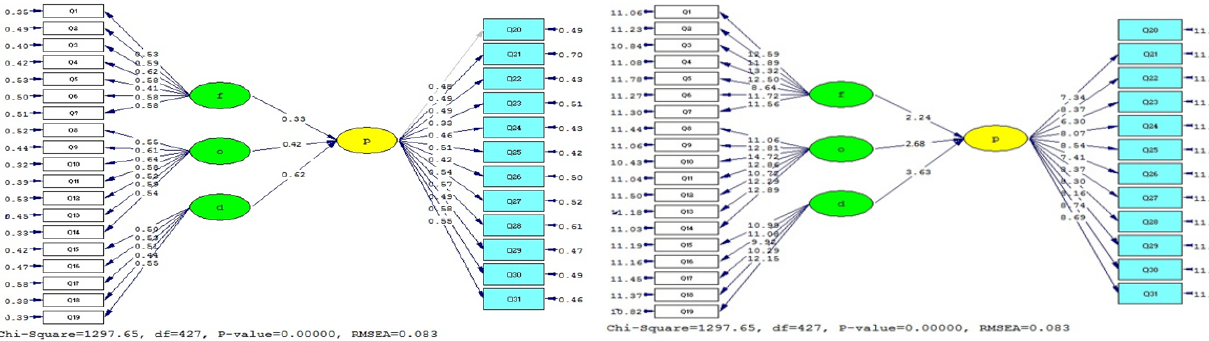
Fig. 2. The summary of standard values Fig. 3. The summary of t-student